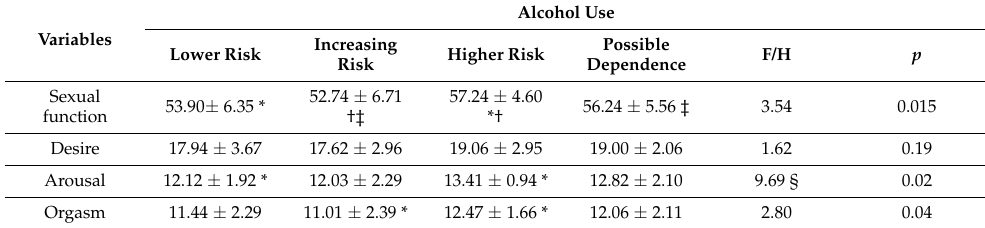
Table 5. The relationship between alcohol use and sexual